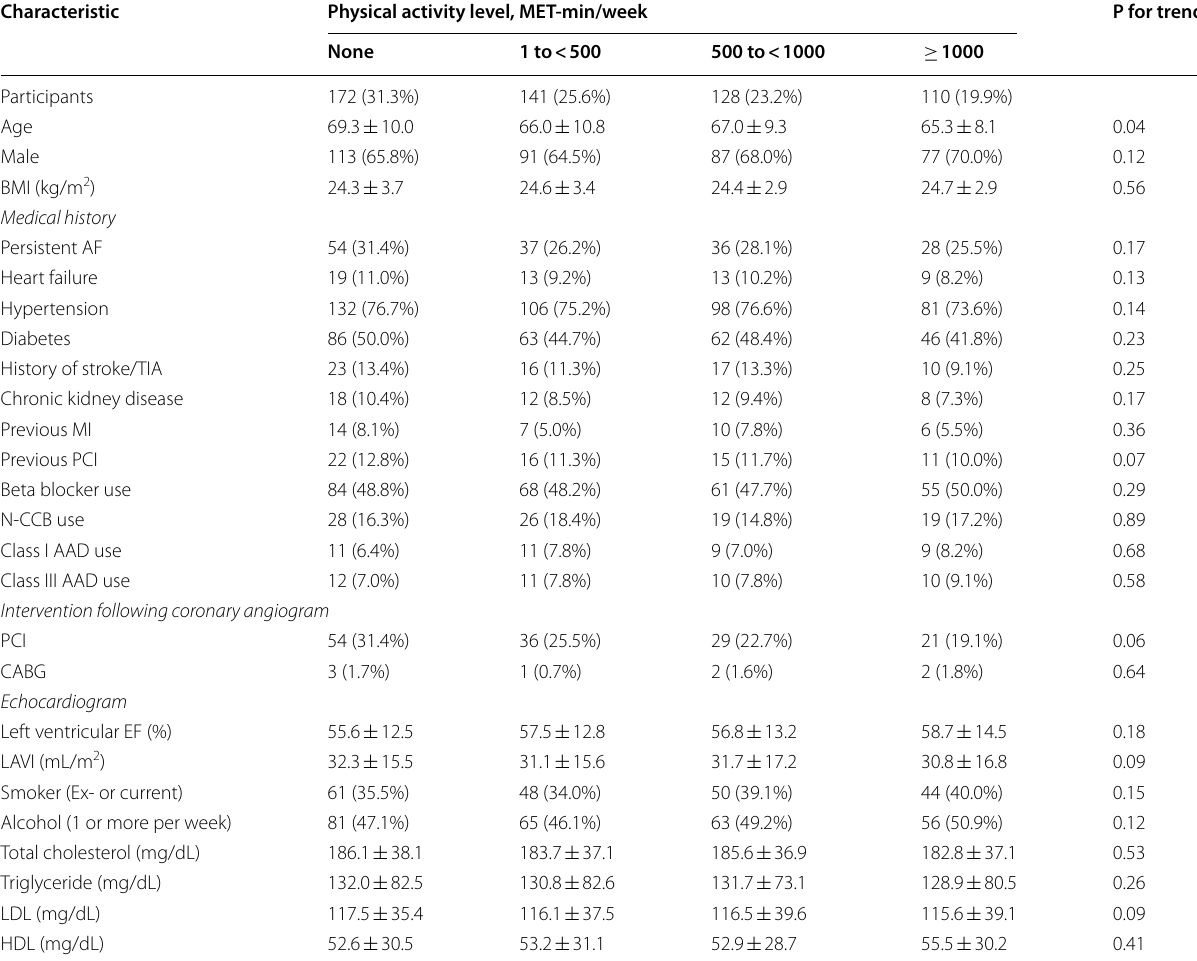
Table 1 Baseline characteristics stratified by the physical activity